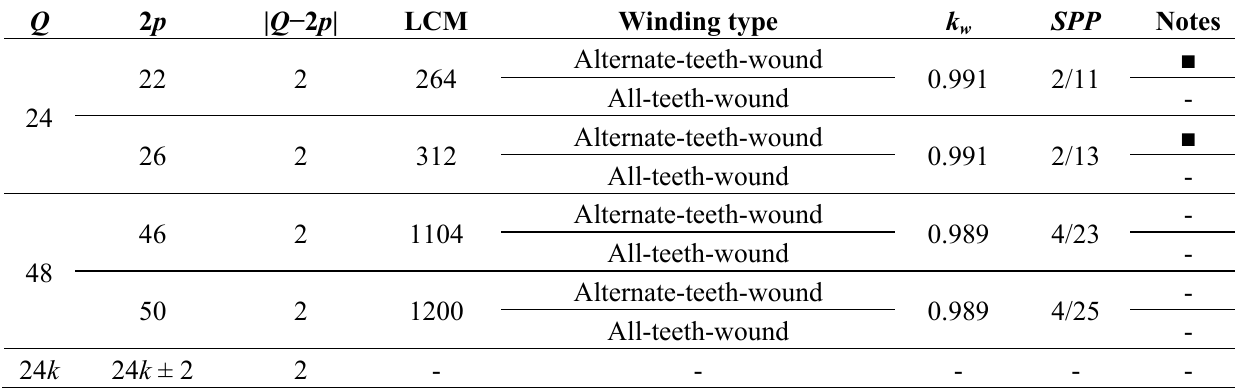
Table 2. Possible slot/pole combinations of the asymmetric six-phase PMSM equipped with FSCWs. Notes: ■ means the combinations enable alternate-teeth-wound design and have highest winding